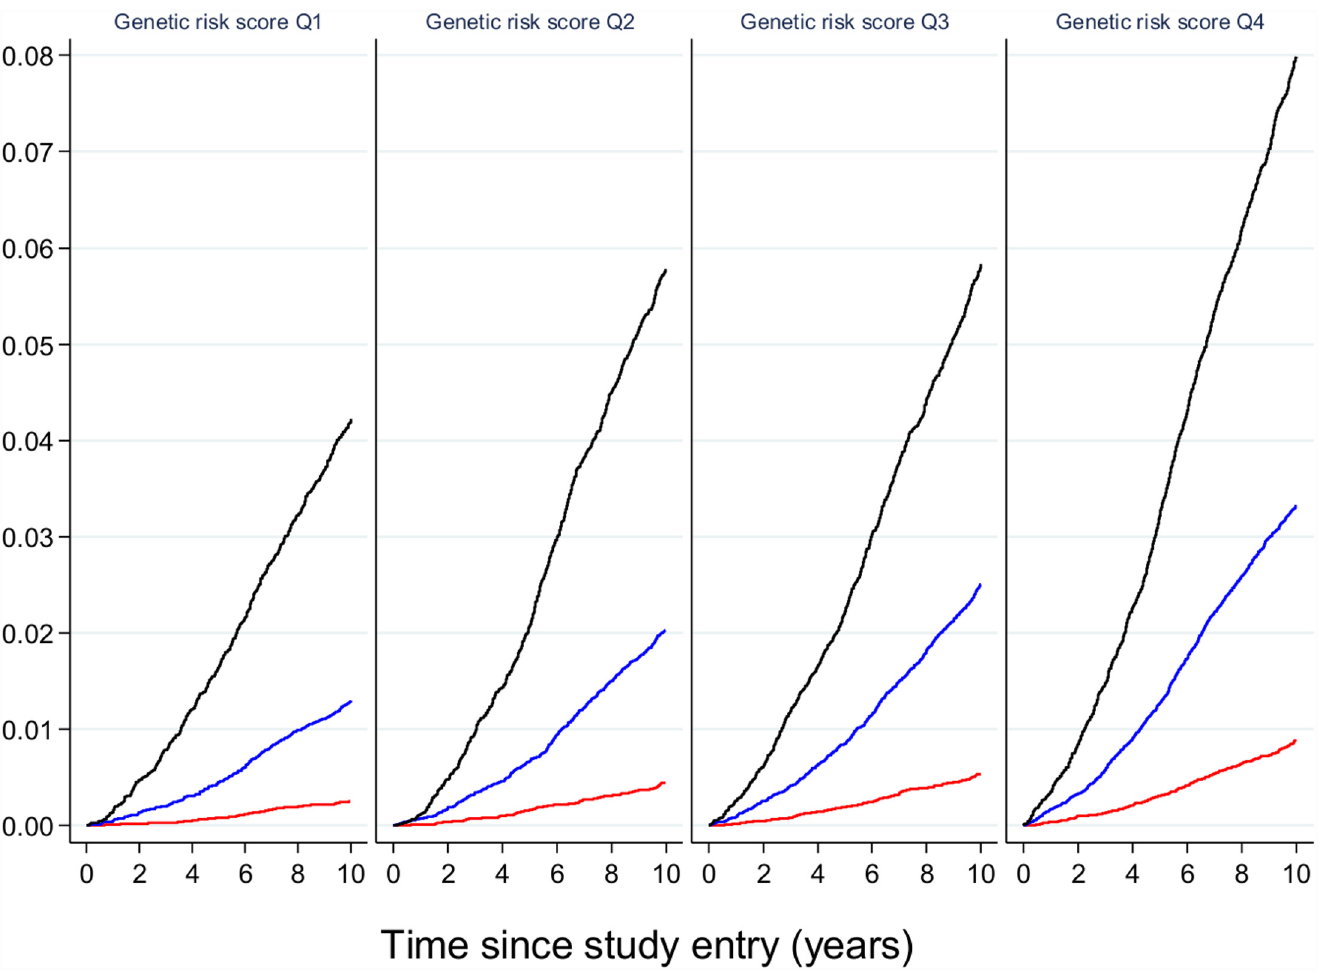
Fig 3. The relative effect of genetic risk and obesity on future type 2 diabetes. Participants in the EPIC-Interact study were stratified by quartiles of genetic risk and by strata of adiposity (obese in black, overweight in blue, and normal weight in red). The likelihood of developing type 2 diabetes is shown, indicating that obese participants with the lowest genetic burden have a higher absolute risk of diabetes than lean or overweight participants with the highest genetic burden. Image is from Langenberg et al.